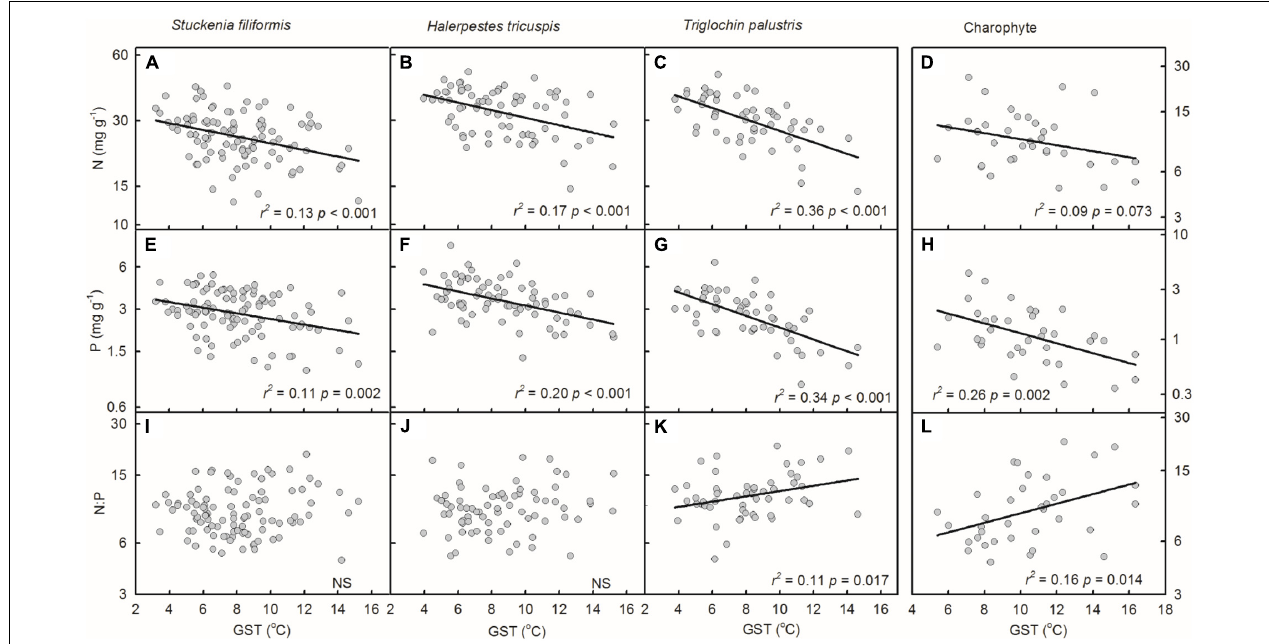
FIGURE 3 | Trends of plant N and P concentrations and N:P ratios along temperature gradients (A–L) . The growing season mean temperature (GST) was used to test the effects of temperature on plant N and P concentrations and N:P ratios. The p -value in each panel was the original one of each test if it was smaller than the corrected one obtained by Holm’s Sequential Bonferroni Procedure. If not, the test was non-significant